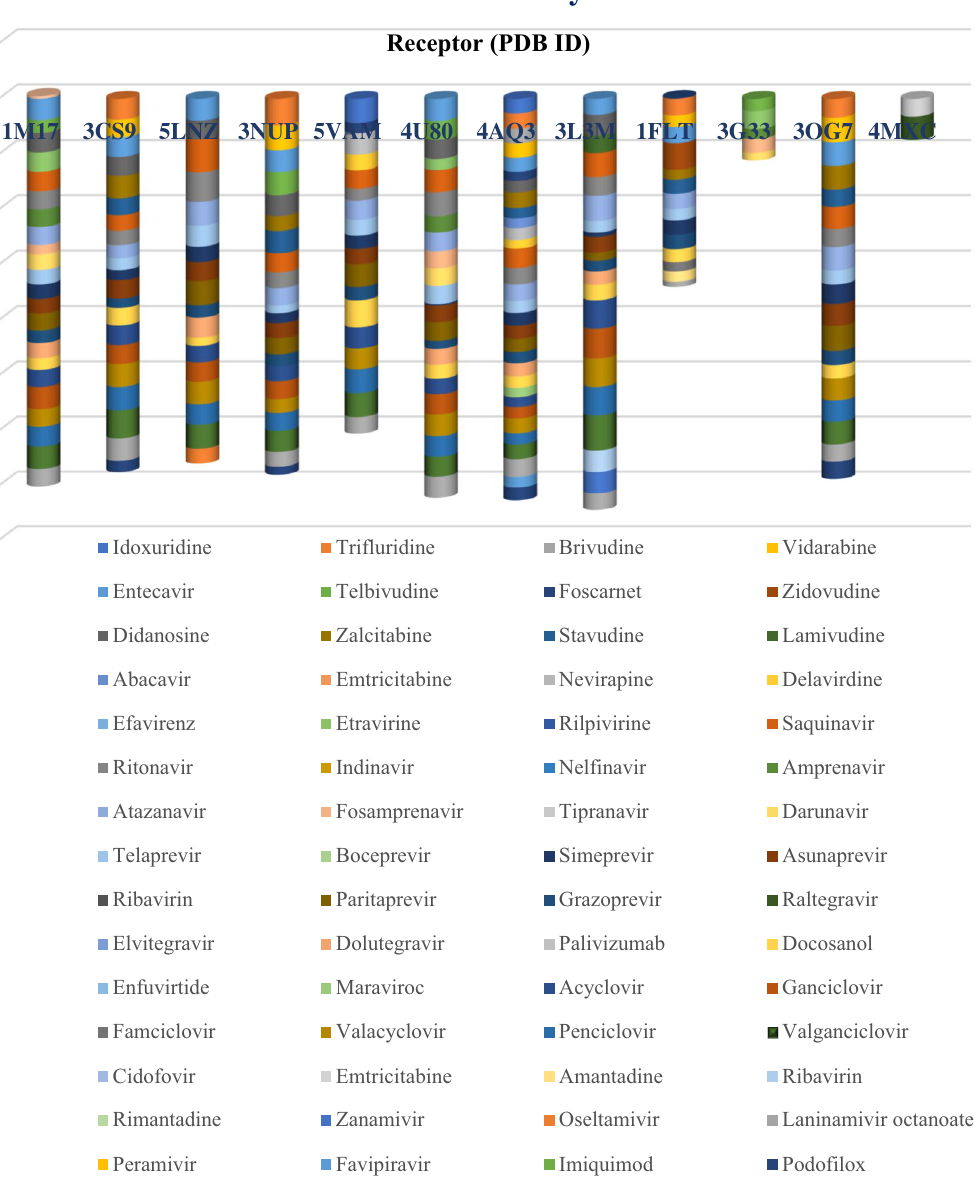
Figure 1. D-score analysis of sixty FDA approved drugs against selected twelve anticancer targets. (Each cylinder corresponds to a particular protein, represented by its PDB ID and the different ligands are represented by color codes as given under the plot. The D-score value of the ligands in a receptor are comparable to the width of the color